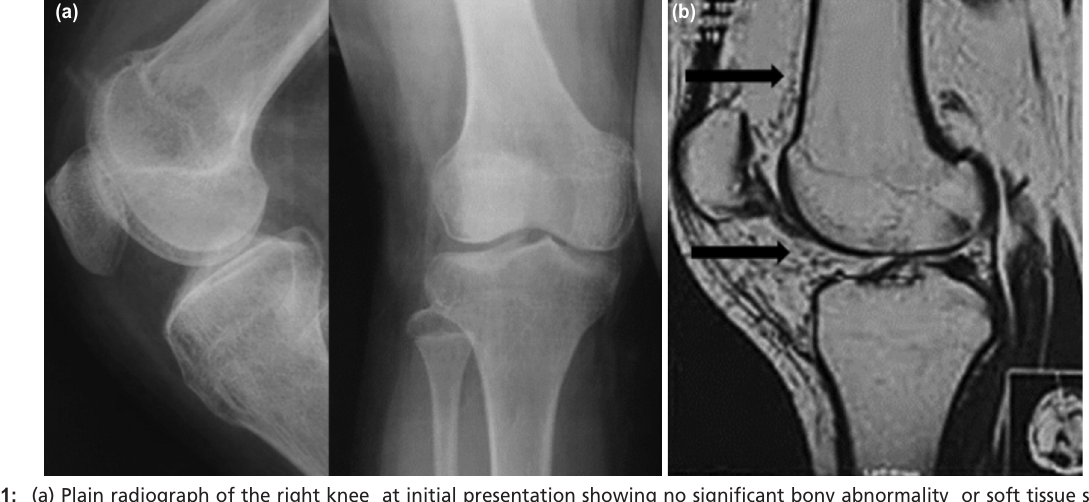
(a) Plain radiograph of the right knee at initial presentation showing no significant bony abnormality or soft tissue swelling. Fig. 1: (b) The MRI of the right knee suggests infection, . reported as an aggressive lesion, possibly osteomyelitis of the distal femur with subperiosteal abscess associated with enhancing synovium (black arrow). The mixture of high and low signals within the synovium might represent highly vascularised synovial tissues with low signals hemosiderin deposited tissues.